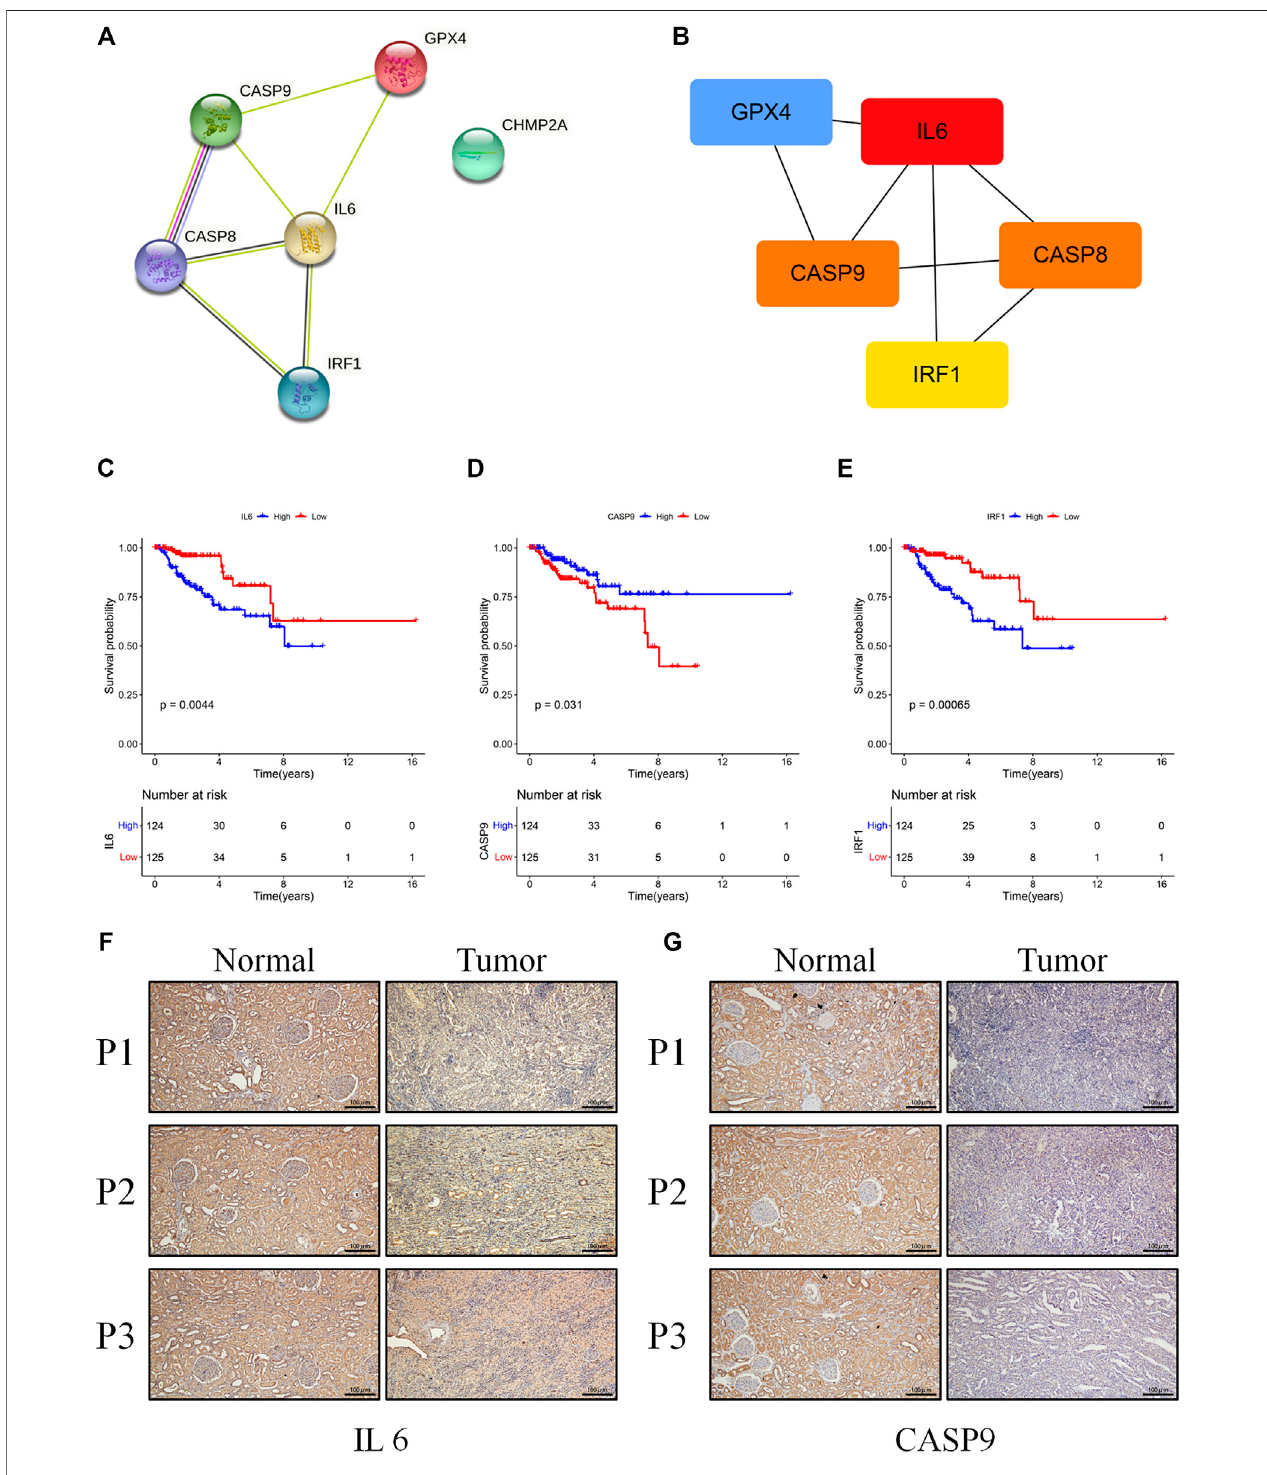
FIGURE7|(A) ThePPInetworkwasconstructedcontainingsixgenesofthesignature. (B) ScreeninghubgenesfromthePPInetwork(rednode:geneswithahigh MCC score; blue node: genes with a low MCC score). (C – E) The cohort was divided into two groups (high and low) according to their median expression value separately, and the expressions of IL6 , RAF1 , and CASP9 were associated with overall survival ( p < 0.05). (F,G) Results of IL6 and CASP9 in immuno-histochemical staining between KIRP and normal tissues (scale bar values: 100 µm).